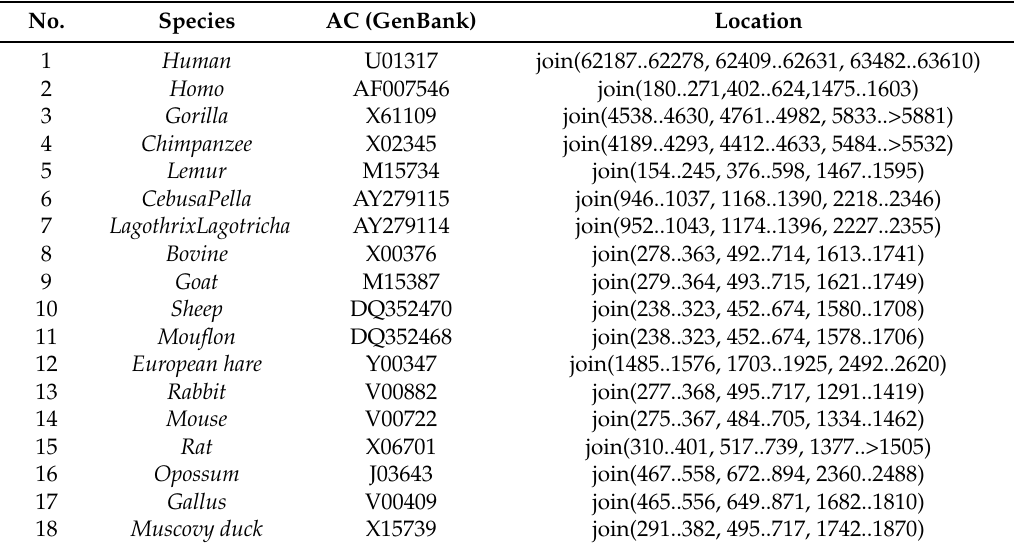
Table 3. The CDS (Coding DNA Sequence) of β -globin gene of 18